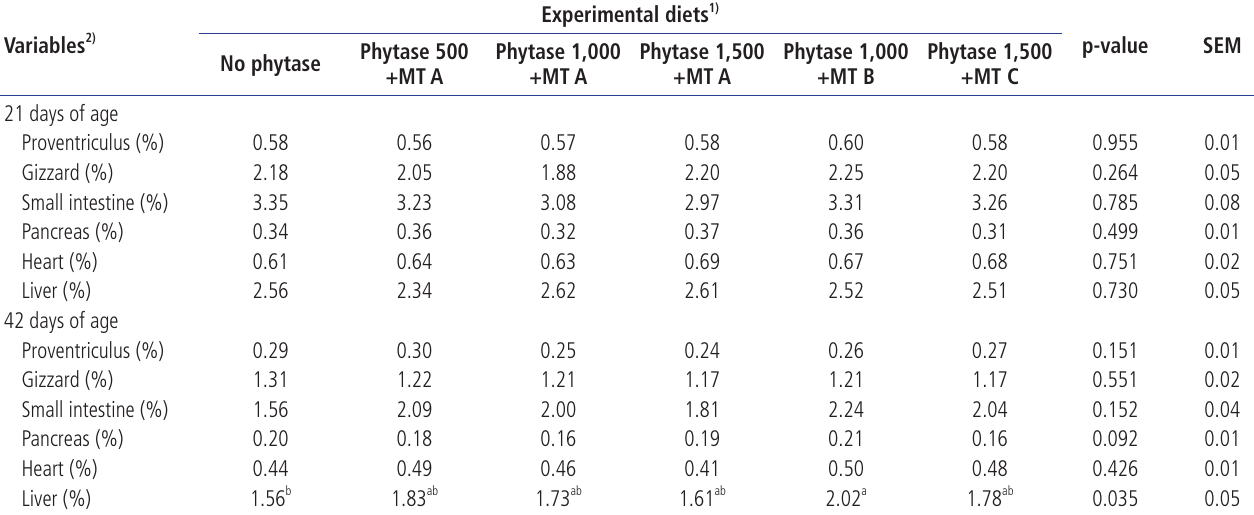
SEM, standard error of the means. 1) Matrix A (MT A): 0.165% Ca, 0.150% avP, and 0.035% Na; matrix B (MT B): 0.215% Ca, 0.195% avP, and 0.045% Na; matrix C (MT C): 0.245% Ca, 0.225% avP, and 0.053% Na. Table 7. Relative organ weights of broilers fed diets supplemented with phytase at 21 and 42 days of age Variables 2)